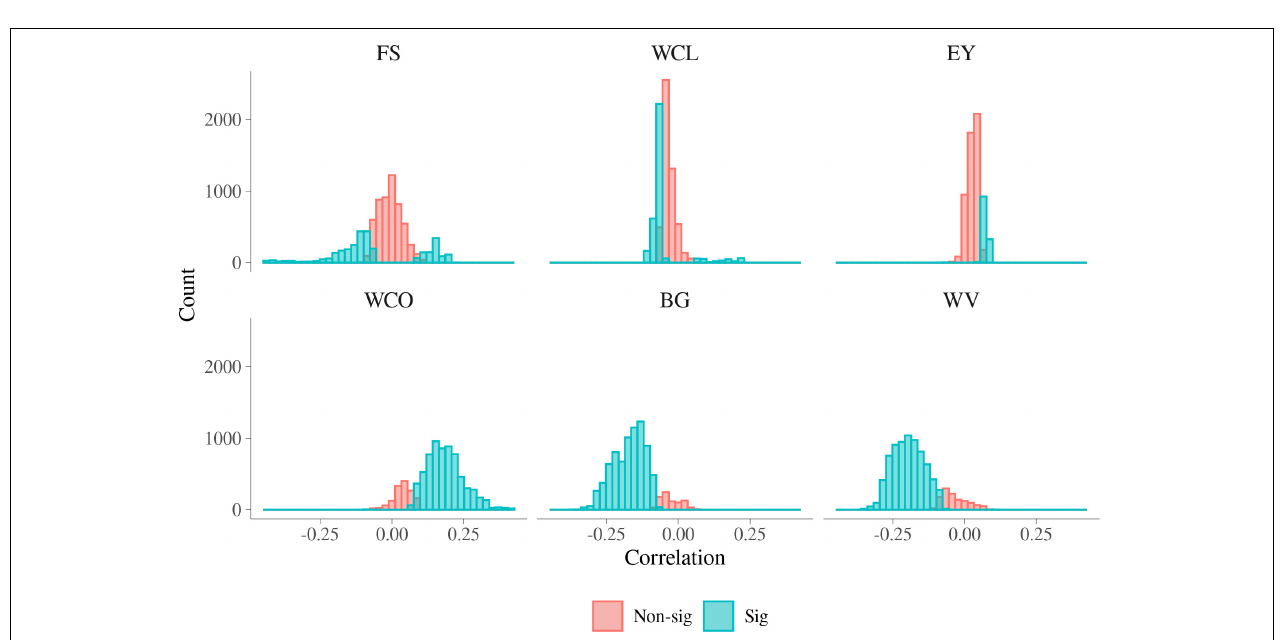
from 3 to 4.5 ppm in the NMR spectrum is dominated by